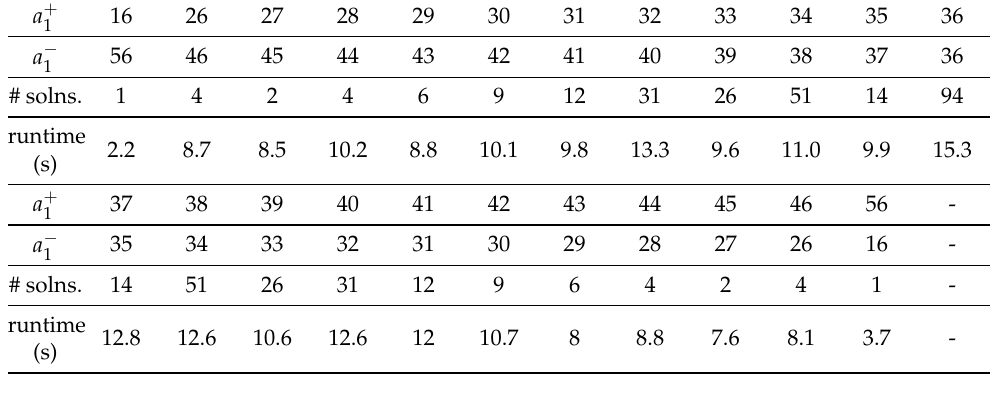
Table 2. Number of tiling solutions (# solns.) and runtimes in seconds for CPLEX to find the feasible solutions of the pariomino tiling problem in Example 2.